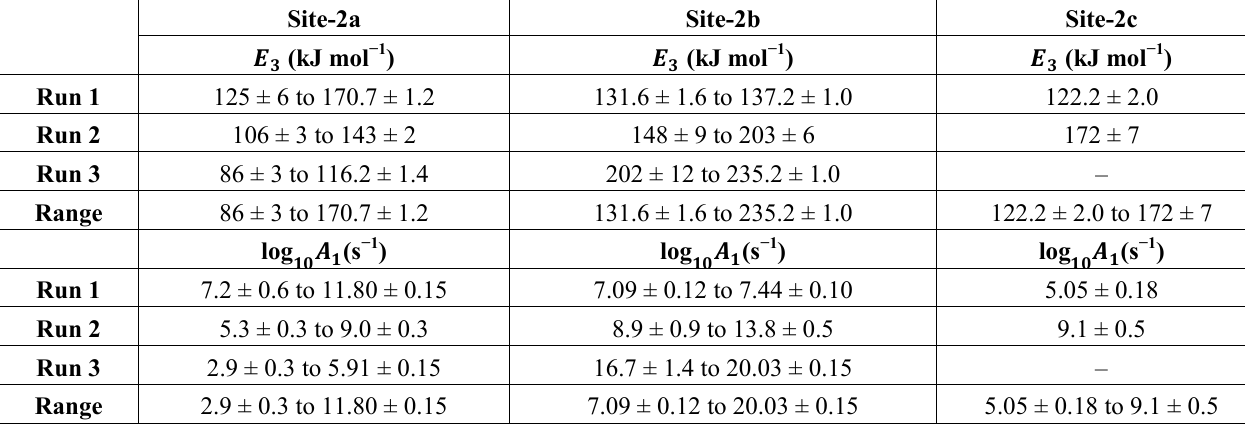
Table 5. Intrinsic isobutane dehydrogenation activation energies ( (cid:1831) ) calculated from Equations (15) and (16) for the three runs. Isobutane frequencies ( log (cid:1827) (cid:2869)(cid:2868) (cid:2869) diffusion activation energy is (cid:1831) (cid:3404) 32.2 kJ mol − 1 [1] and (cid:1831) (cid:2879)(cid:2870) log (cid:1827) : (cid:1827) (cid:3406) 0. (cid:2869)(cid:2868) (cid:2871) (cid:2879)(cid:2870) Site-2a